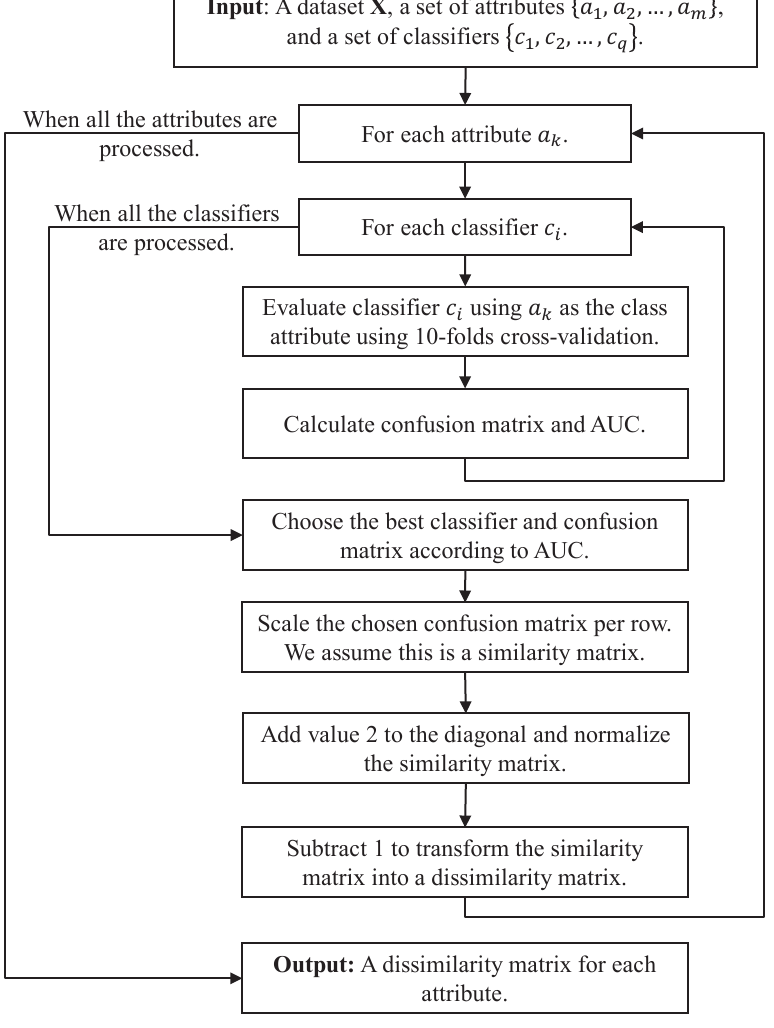
Figure 1. Flow diagram for the procedure of computing Learning-Based